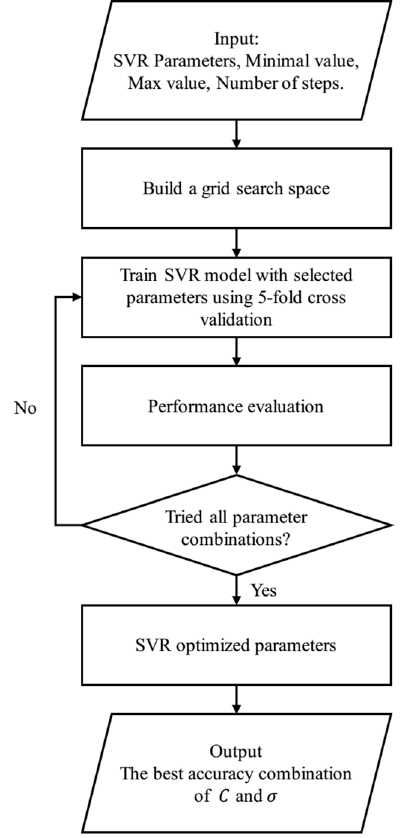
Figure 3. SVM parameter optimization using grid search.